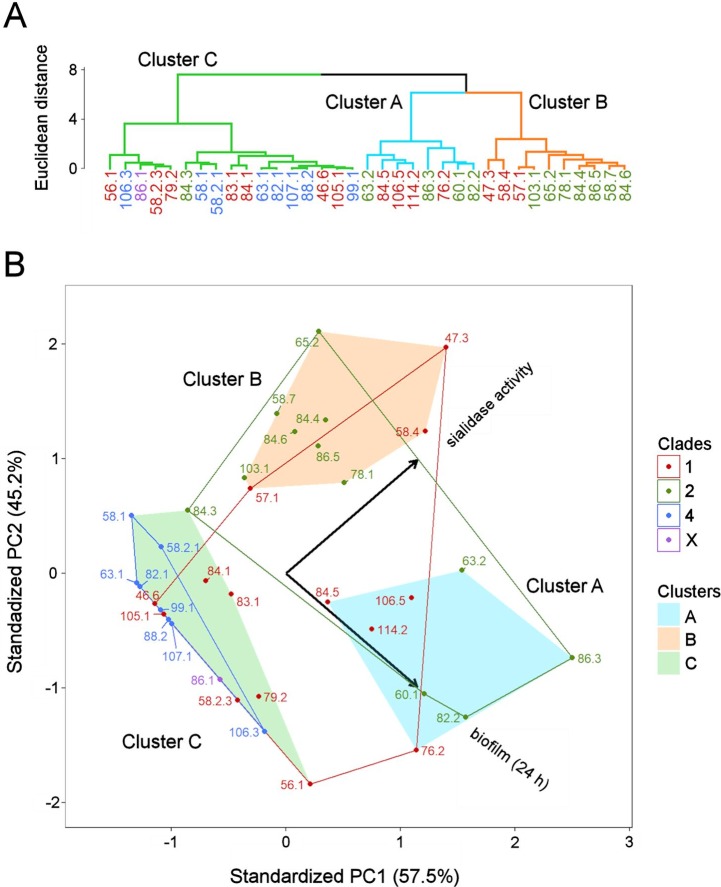
Results of hierarchical clustering and principal component analysis based on two characteristics: Sialidase activity and biofilm amount after 24 h incubation.(A) Dendogram that shows similarity between the G. vaginalis isolates. The colors of the branches represent the three largest clusters. (B) PCA biplot. Axes represent the first and the second principal components (PCs). Percentages on the axes indicate the percentage of the total variance explained by each PC. Arrows in the biplot represent the phenotypic characteristics. Dots indicate isolates, and the colors of the dots/isolate numbers correspond to particular clades. Closed lines indicate the areas in the space of PCs restricted by the isolates of the same clade. Shaded fields indicate areas restricted by the clusters determined in the dendogram.